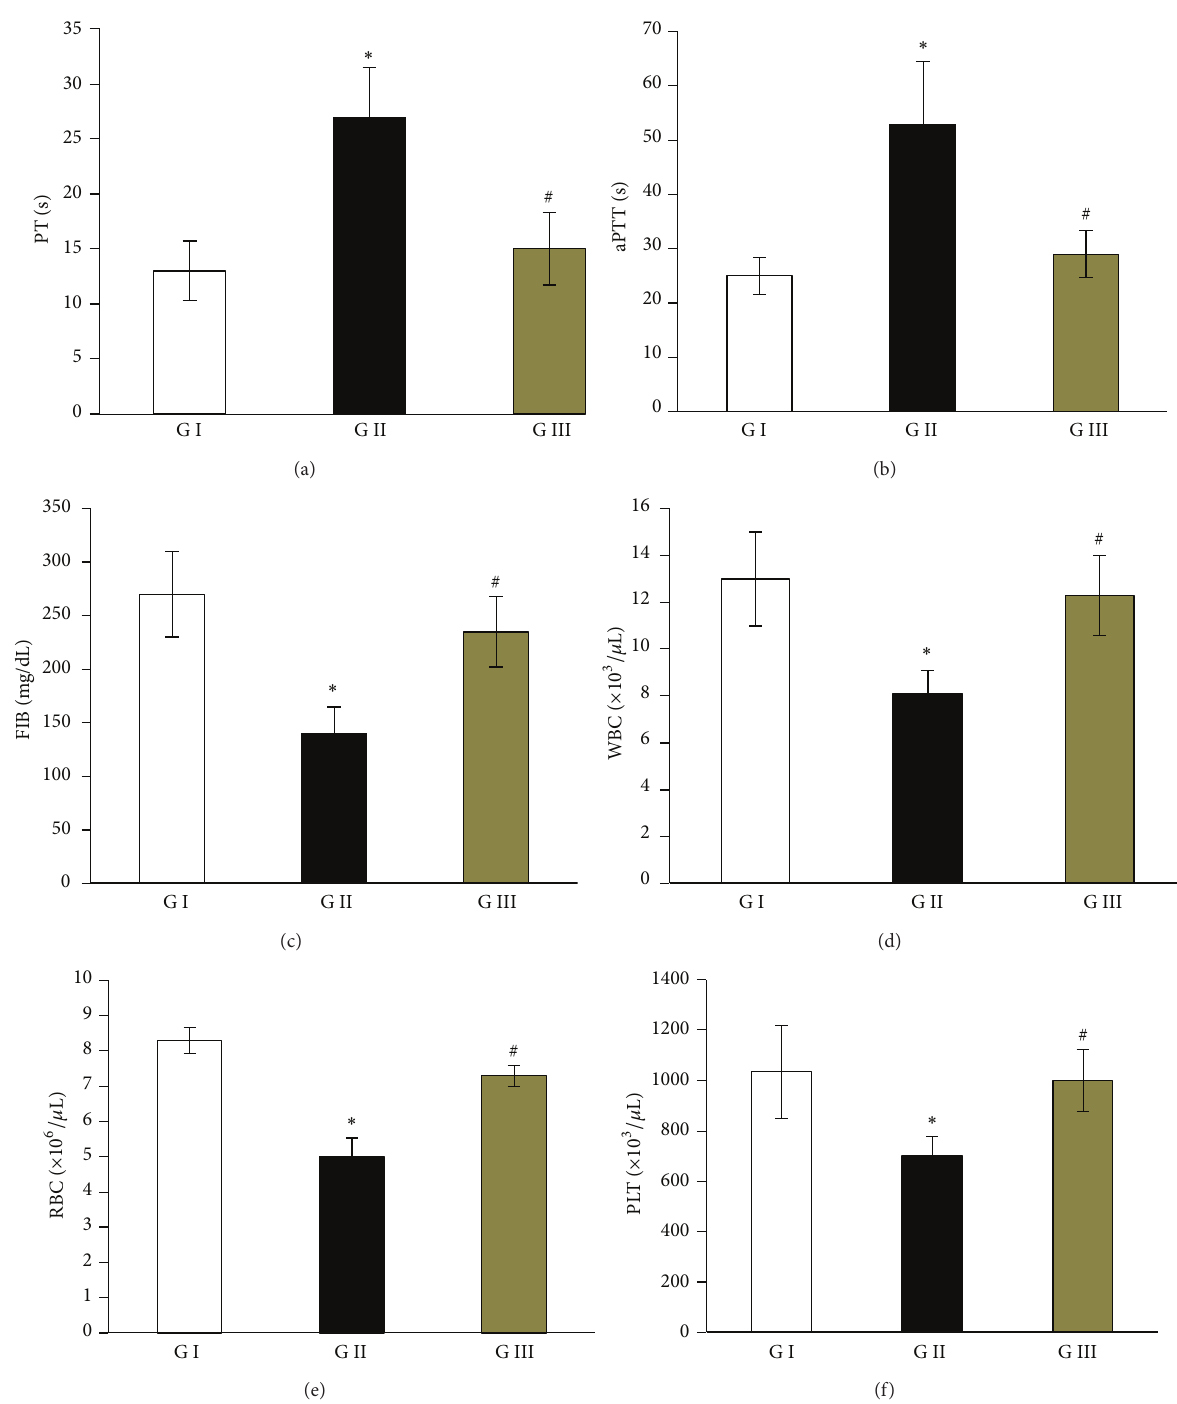
Figure 2: Alleviatived effects of IL-22 therapy on the alterations of blood coagulation tests and blood cell counts in D-GalN/LPS injected rats. GI: control group, GII: D-GalN/LPS group, and GIII: D-GalN/LPS + IL-22 group. Values are represented as mean ± SD. ∗ 𝑃 < 0.05 versus control group; # 𝑃 < 0.05 versus D-GalN/LPS untreated